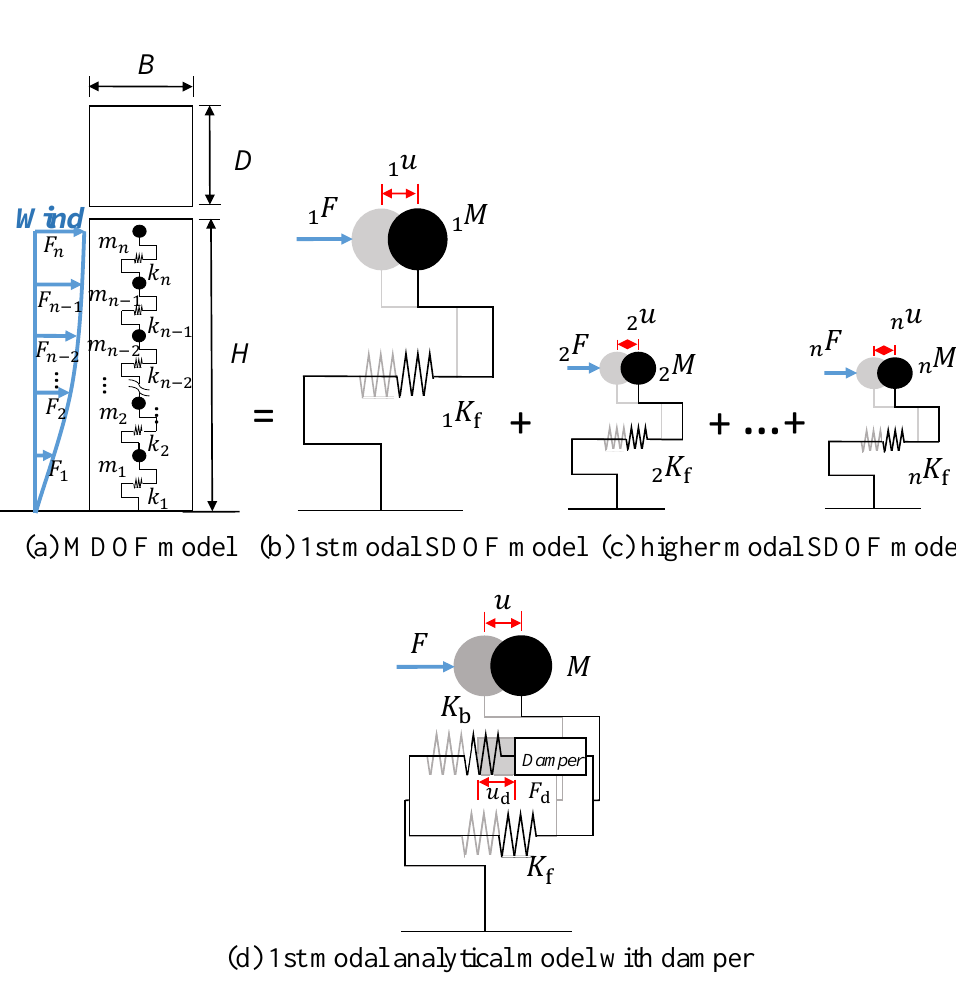
Figure 3. Schematic diagram of modal analysis and target building and 1st modal analytical models. Table 1. Parameters of the 1st modal